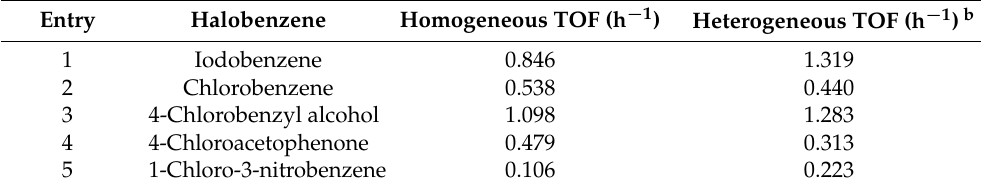
Table 4. Heterogeneous reactions with representative substrates a